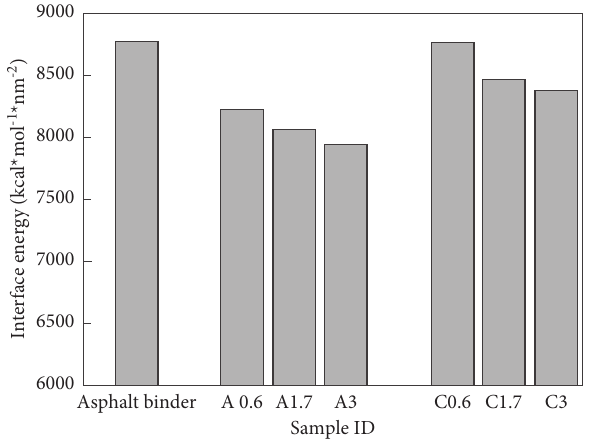
Figure 8: The interface energy results of three kinds of samples. Table 1: ANOVA of density, CED, and interaction energy. Significance of variable Source Interaction